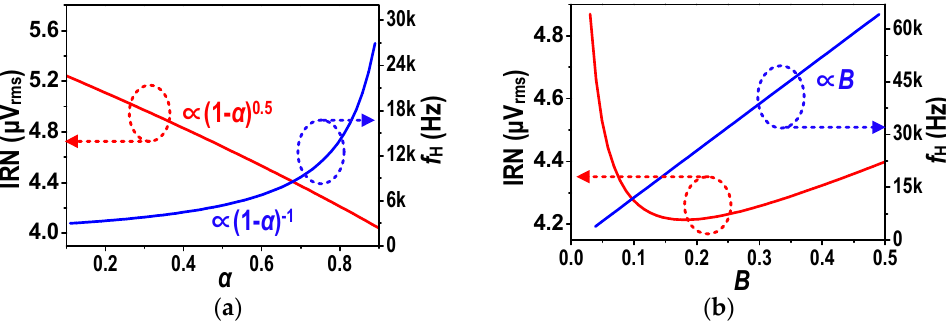
Figure 5. Numerical simulations for the IRN and f H while sweeping α and B in the operational transconductance amplifier (OTA) with a local positive feedback: ( a ) IRN and f H vs α sweep with B = 0.1; ( b ) IRN and f H vs. B sweep with α = 0.7.